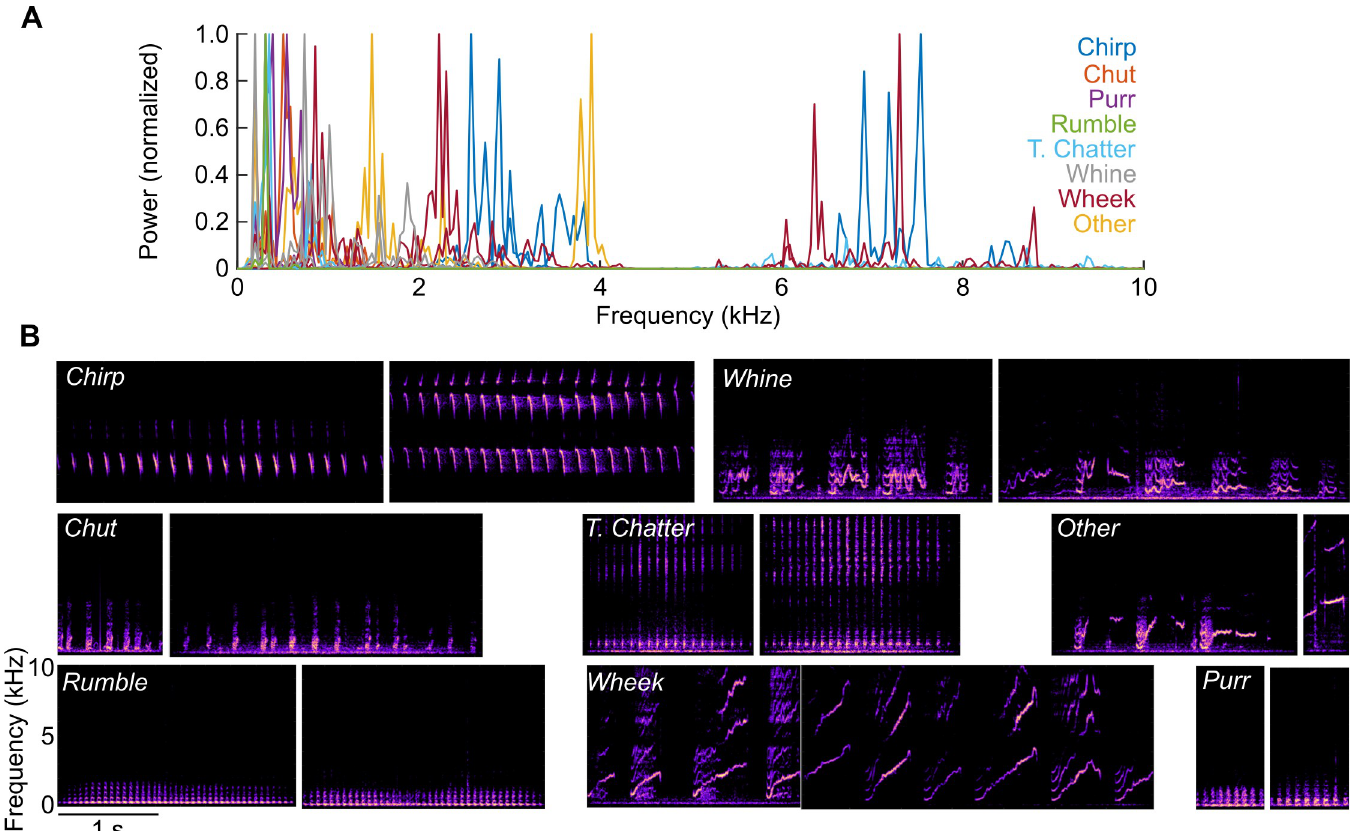
Fig 2. Spectra and spectrograms of GP calls. (A) Normalized power spectra of the GP calls used in this study. Colors correspond to different call categories. (B) Spectrograms of the GP calls used in this study (8 categories, 2 calls per category). Data underlying this figure can be found in Supporting information file S2 Data. GP, guinea